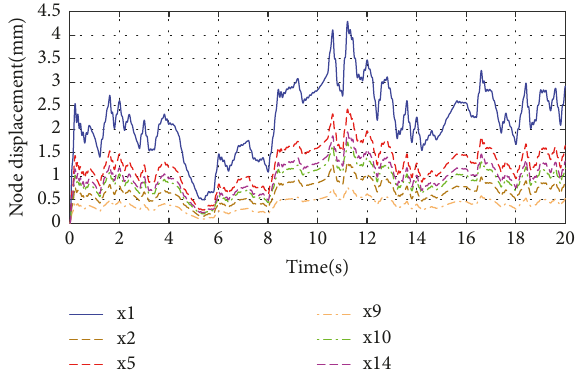
Figure 12: The nodal displacement obtained from dynamic model.